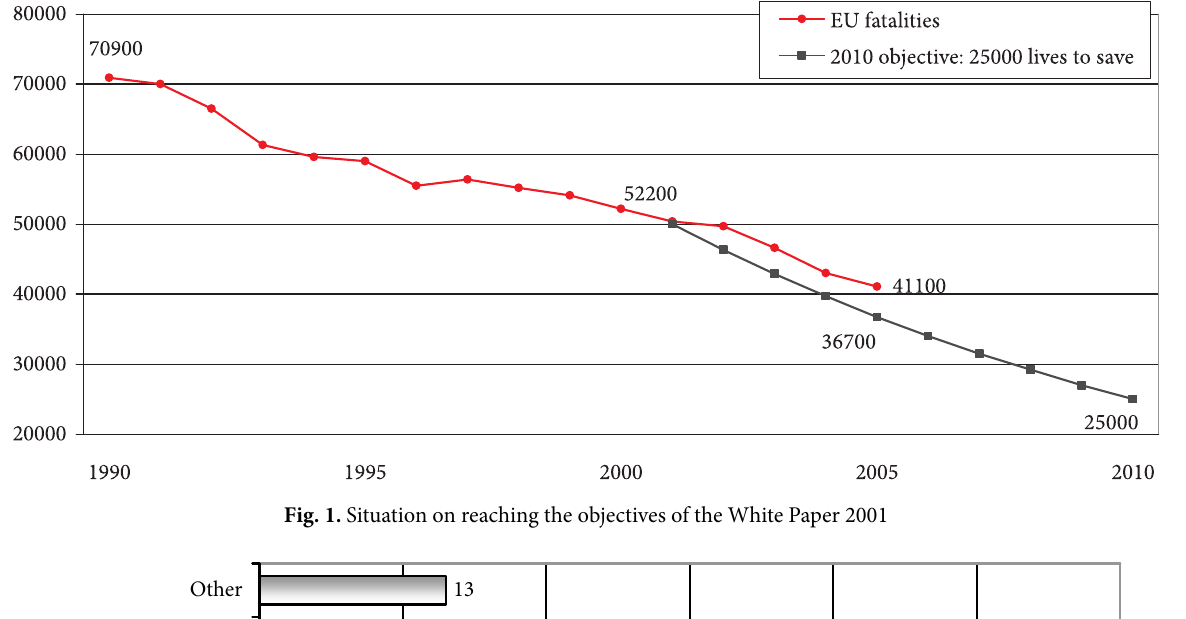
Fig. 1. Situation on reaching the objectives of the White Paper 2001